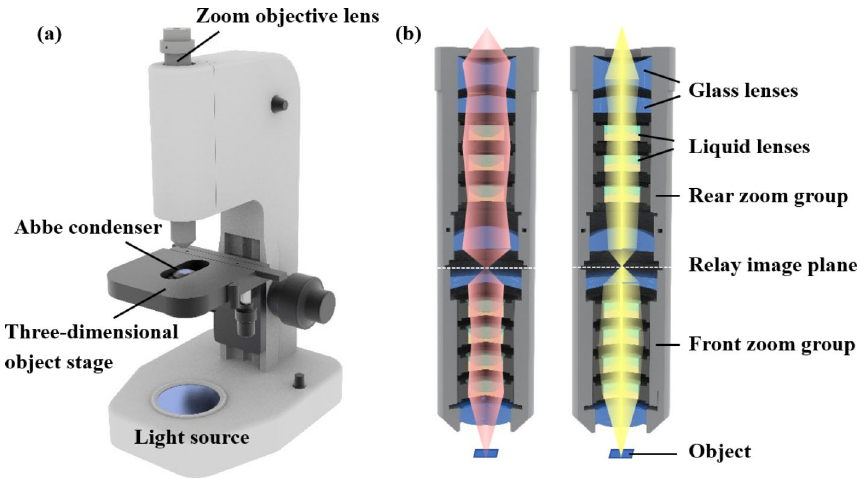
Fig. 1 Schematic structure of the (a) proposed microscope and (b) the zoom objective